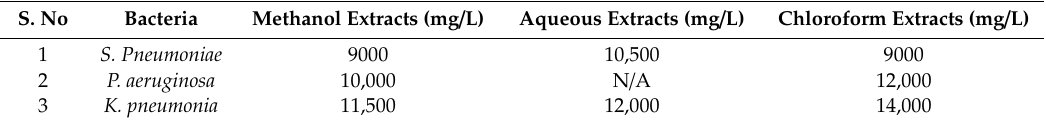
Table 6. Minimum inhibitory concentration (MIC) of Recipe 1 against di ff erent bacterial